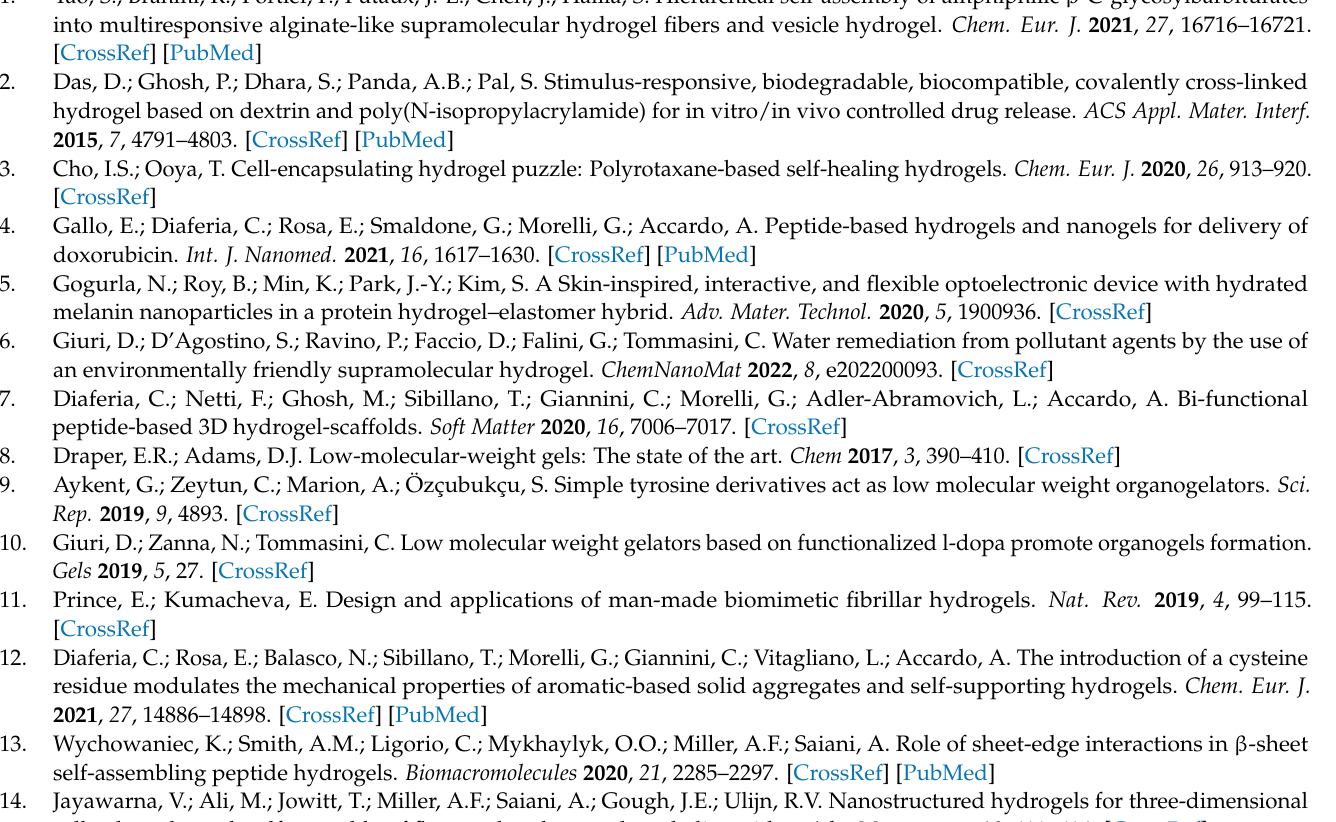
C, D) and meridional (E, F, G, H) profiles for Fmoc-FF HG and PEGDA2-based HGs at the studied molar ratio. Figure S6: Oscillation time sweeps tests for PEGDA1 1/1 (A) and PEGDA1 1/10 (C); frequency time sweeps tests for PEGDA1 1/1 (B) and PEGDA1 1/10 (D). Figure S7: Oscillation time sweeps tests for PEGDA2 1/1 (A) and PEGDA2 1/10 (C); frequency time sweeps tests for PEGDA2 1/1 (B) and PEGDA2 1/10 (D). Table S1: Meridional and equatorial peak positions in q (Å –1 ) and corresponding distance d = 2 π /q (Å) of the mixed hydrogels; in red, the common peak with the Fmoc-FF reference